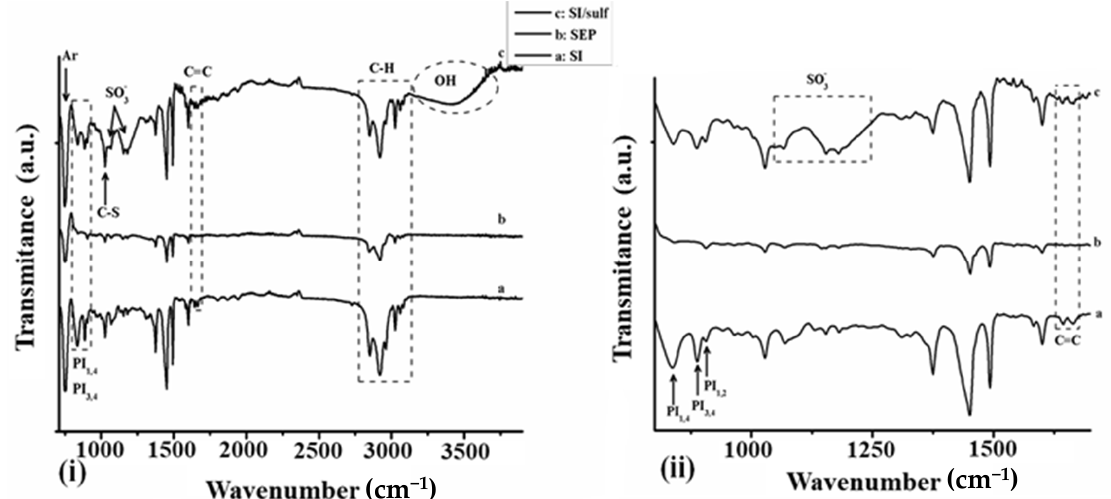
Figure 2. FT-IR spectra of (a) SI, (b) SEP and (c) SI/sulf copolymers indicating the characteristic groups as well as the differences after chemical modification reactions. The spectra in ( i ) correspond to wavelengths from 750 to 3750 cm − 1 and in ( ii ) to magnified areas from 750 to 1750 cm − 1